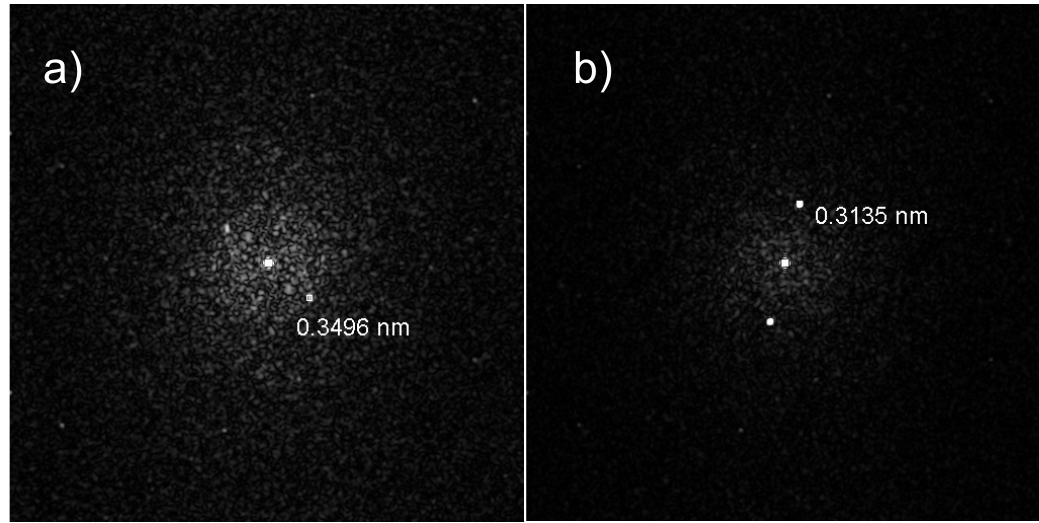
Figure 4. Representative selective area electron diffraction (SAED) diffraction patterns obtained from ( a ) The darker region (TaSi 2 ); and ( b ) Lighter region (Si) of the obtained JL